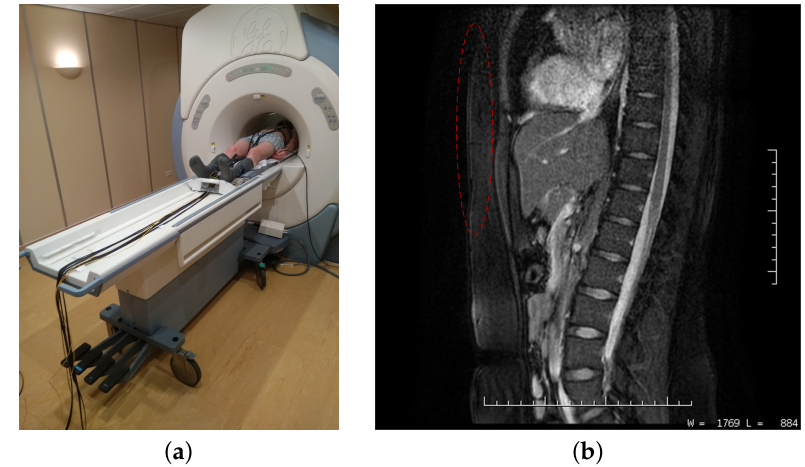
Figure 9. ( a ) Photography from the MRI examination; ( b ) MRI image acquired from the sensor location: sagittal view—test subject M2 (512 × 512